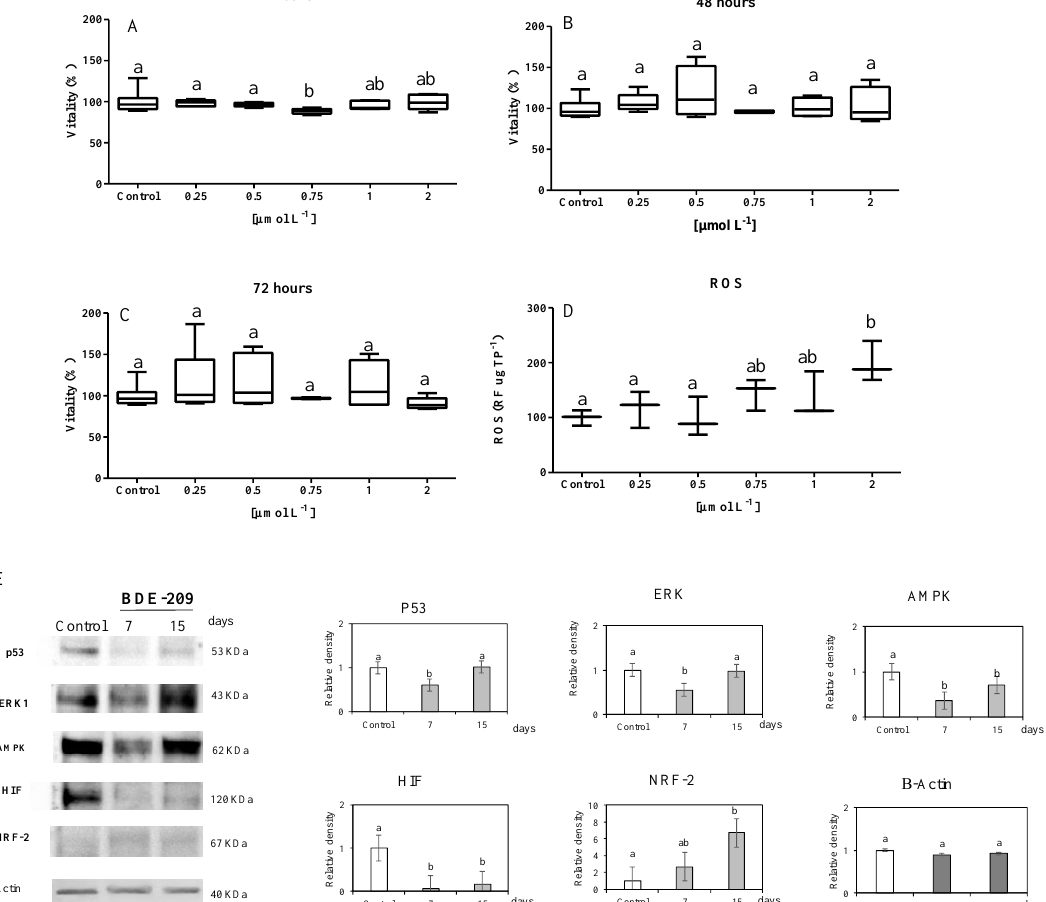
Figure 1. ( A – C ) Cytotoxicity of SAF-1 cells (fibroblast from Sparus aurata ) exposed to different concentrations of polybrominated diphenyl ether-209 (BDE 209) (0.25–2 µ mol L − 1 ) for 24, 48, and 72 h. ( D ) Reactive oxygen species (ROS) production, expressed as relative fluorescence × µ g total proteins − 1 , in SAF-1 cells exposed to different concentrations of BDE 209 (0.25–2 µ mol L − 1 ) for 72 h. ( E ) Immunoblotting of some proteins related to cell cycle (p53), proliferation (ERK), energetic balance (HIF, AMPK), and oxidative stress (NRF-2) in SAF-1 cells control: cell not exposed to the compound. Immunoblotting of actin protein is used as internal control for total proteins. Bars represent the mean ± SEM (n = 6). Statistically significant differences vs. the control (ANOVA; p ≤ 0.05) are denoted using different letters.